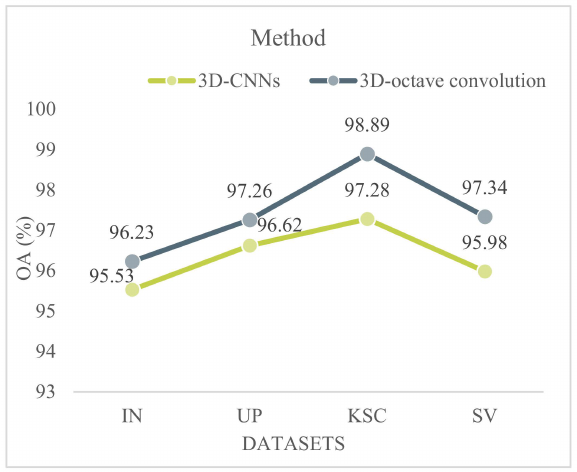
Figure 12. OAs of 3D-CNNs and 3D-OCONV on IN, UP, KSC, and SV datasets